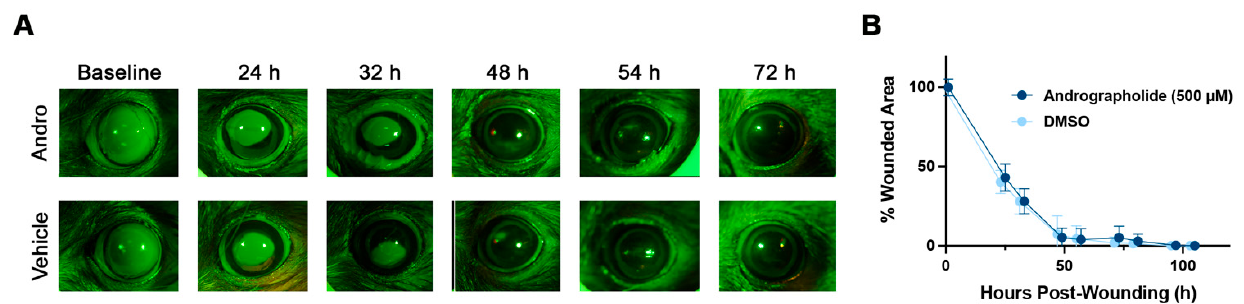
Figure 4. Treatment with topical ophthalmic andrographolide does not affect corneal epithelial wound healing after manual excimer spatula debridement of the corneal epithelium in rats. ( A ) Fluorescein-stained corneas demonstrating complete re-epithelialization of the cornea by 72 h in both andrographolide- and DMSO-treated Long Evans rats. Representative images of fluorescein-stained epithelial wounds in rats treated with andrographolide (500 µ M) or vehicle control (DMSO 0.5%) four times daily. ( B ) There were no significant differences in epithelial wound healing rates in rat globes treated with andrographolide (500 µ M, n = 4 eyes) or vehicle control (DMSO 0.5%, n = 4 eyes) (one way ANOVA with a Šidák’s multiple comparisons test, p > 0.05).